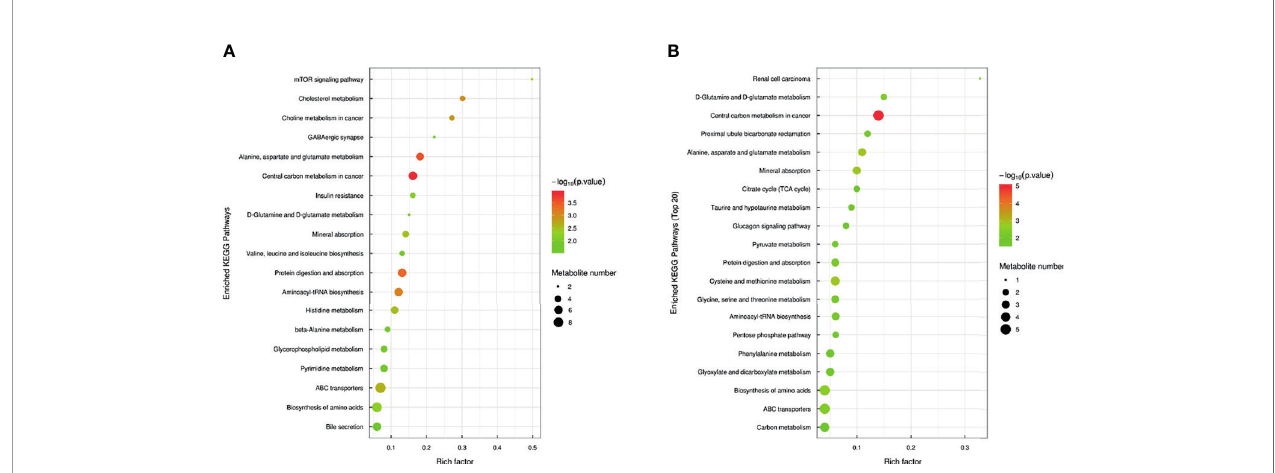
FIGURE 4 | Bubble plot of the pathway analysis of Nb vs. NC (A) and ES vs. ES-blank (B) . A metabolic pathway is represented by each bubble in the bubble chart. In the topological analysis, the pathway is in fl uenced by factors such as the size and abscissa of the bubble. The ordinate and color of the bubble with the latter indicating the p -value of the enrichment analysis. The darker the color, the smaller the p -value and the more signi fi cant the enrichment degree. The rich factor represents the ratio of the different metabolites in the pathway to the detected